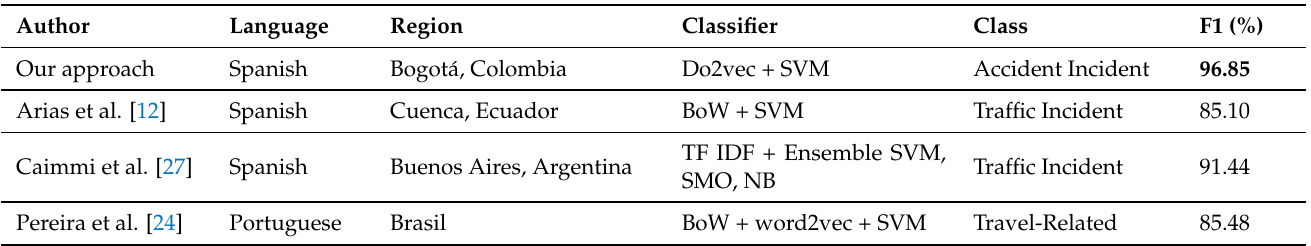
Table 11. Comparison between related studies and the proposed classification model in terms of language, region and F1